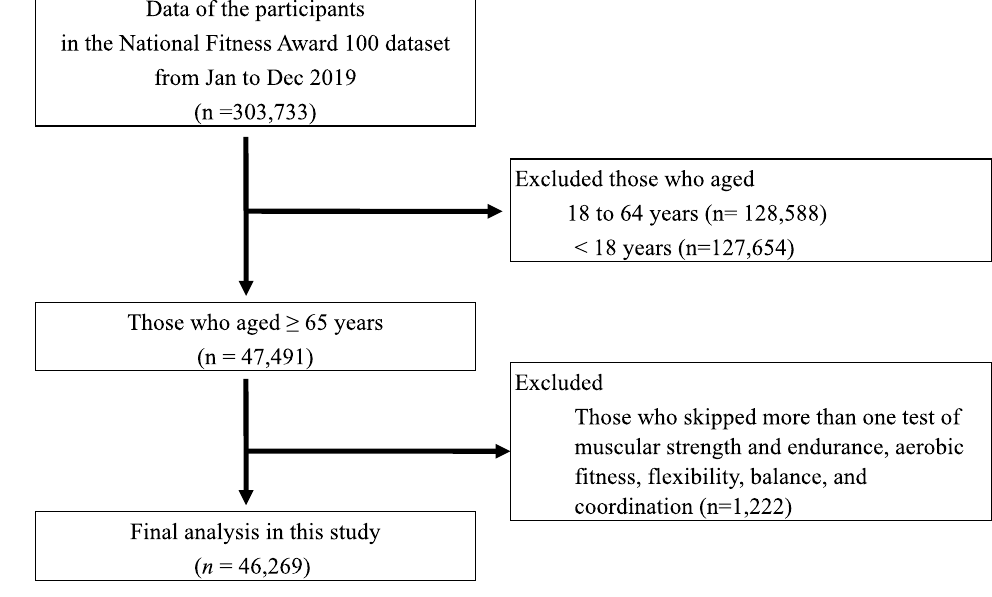
Figure 3. Flow chart of the sample analyzed in this